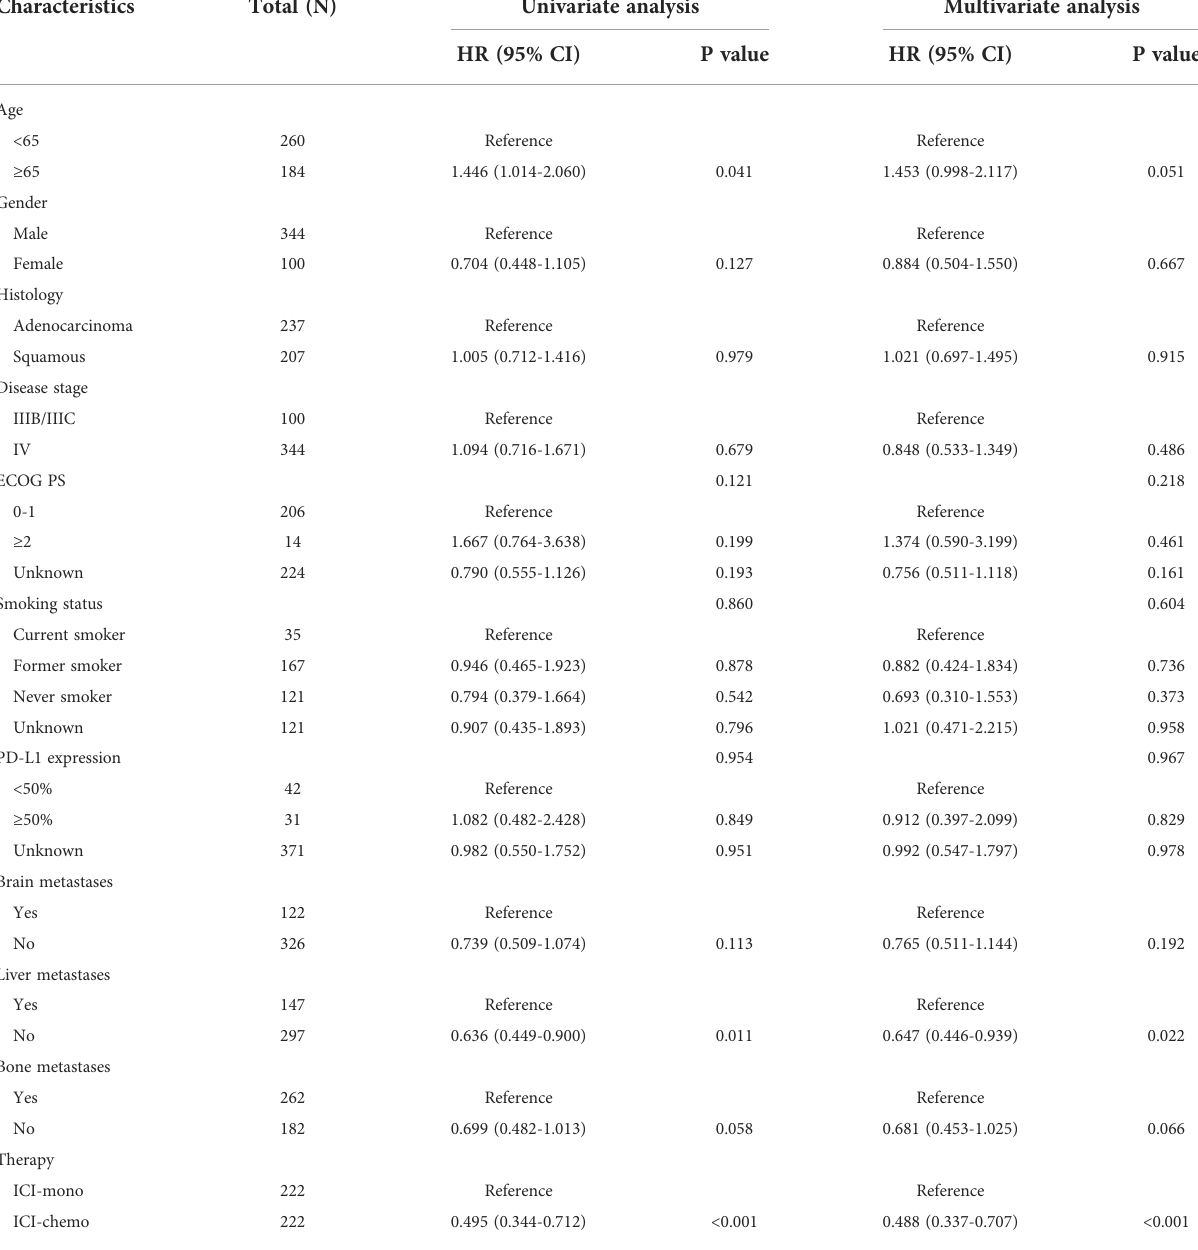
TABLE 2 Univariable and multivariable analyses of overall survival in patients after propensity score